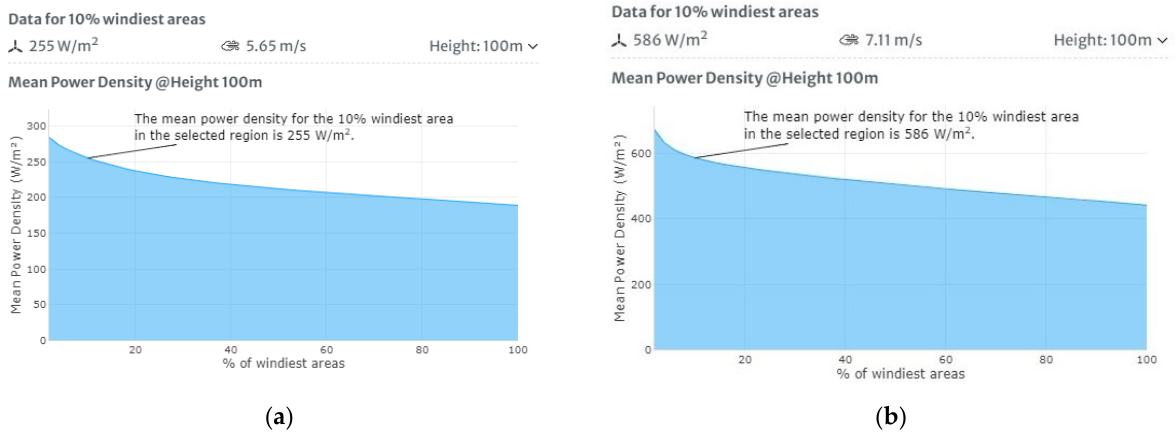
Figure 3. Wind power density of the Kolubara ( a ) and Kostolac ( b ) coal basins areas.